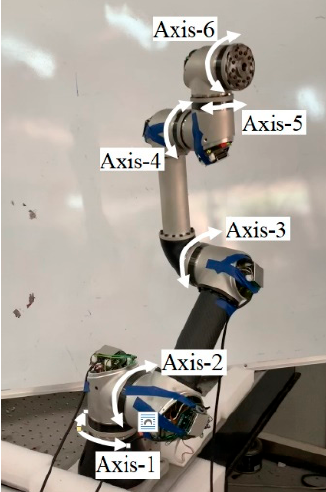
Figure 7. A prototype of six-degree-of-freedom (6-DOF) collaborative robot.